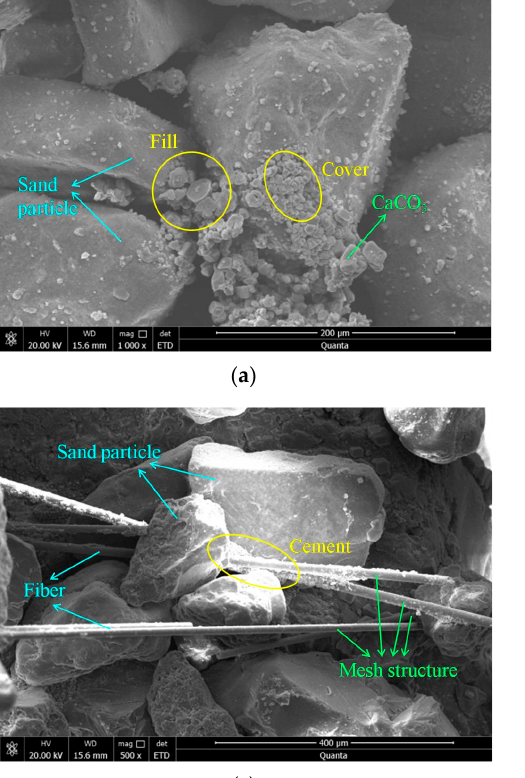
( b ) Figure 8. Curves of unconfined compressive strength versus CaCO 3 content ( a ) ρ d = 1.5 g/cm 3 ; and ( b ) ρ d = 1.6 g/cm 3.